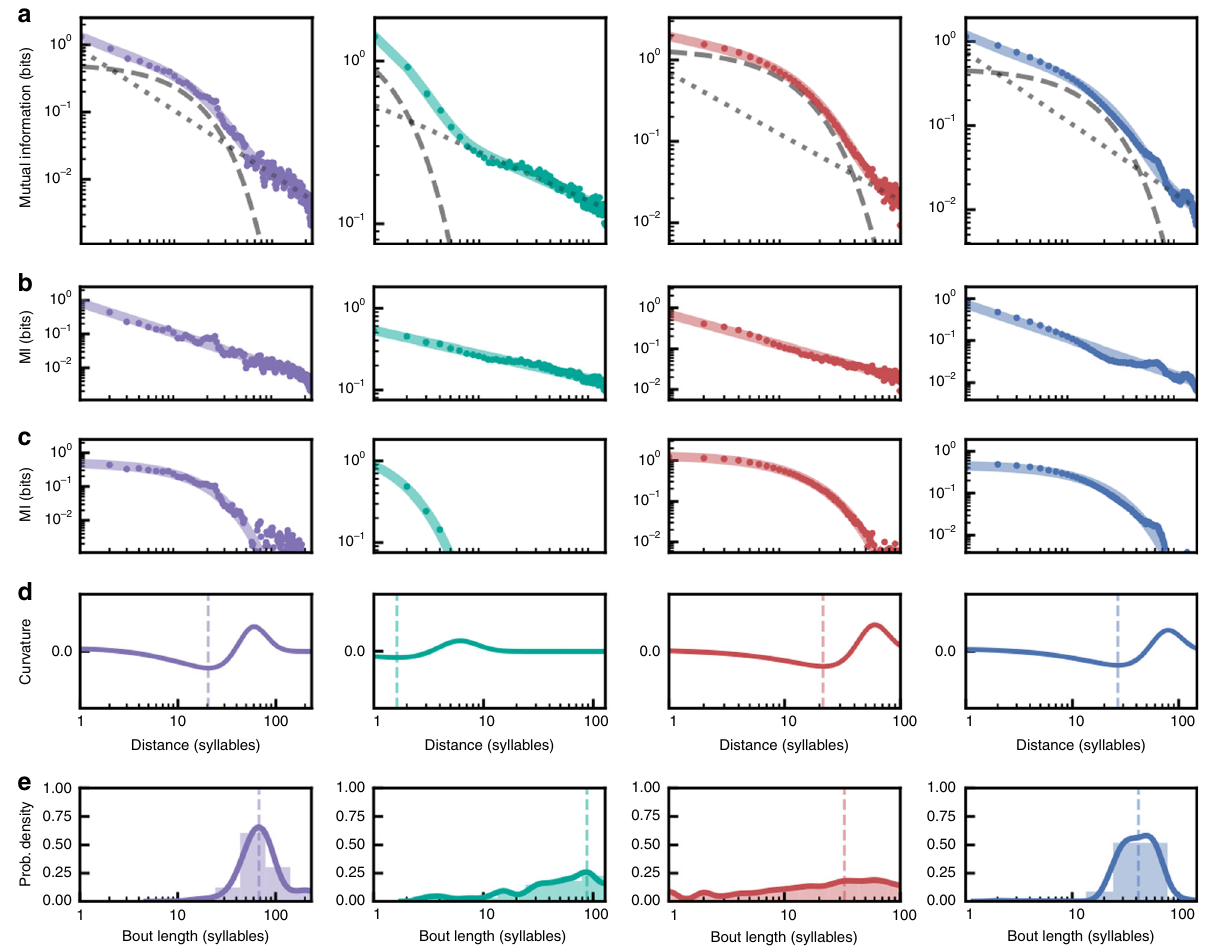
Fig. 4 Mutual information decay in birdsong. a MI decay in song from four songbird species (purple: Bengalese fi nch, teal: California thrasher, red: Cassin ’ s vireo, blue: European starling) as a function of the sequential distance between syllables. MI decay in each species is best fi t by a composite model (colored lines) with exponential and power-law decays, shown as a dashed and dotted gray lines, respectively. b The MI decay (as in a ) with the exponential component of the fi t model subtracted to show the power-law component of the decay. c The same as in b , but with the power-law component subtracted to show exponential component of the decay. d Curvature of the fi tted composite decay model showing the distance (in syllables) at which the dominant portion of the decay transitions from exponential to power law. The dashed line is drawn at the minimum curvature for each species (Bengalese fi nch: ~24, California thrasher: ~2, Cassin ’ s vireo: ~21, European starling: ~26) e Histograms showing the distribution of bout lengths in syllables, fi t with a smoothed Gaussian kernel (colored line). The dashed line shows the median bout length (Bengalese fi nch: 68, California thrasher: 88, Cassin ’ s vireo: 33, European starling: